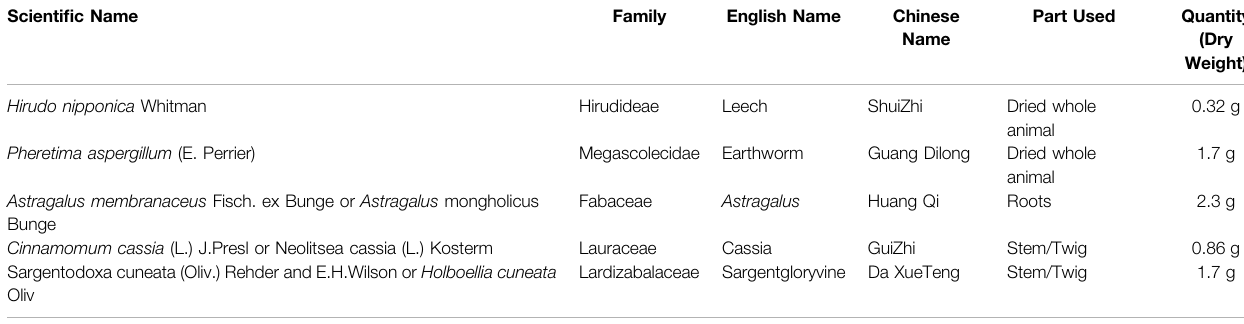
TABLE 1 | Components of Zhilong Huoxue tongyu capsule.